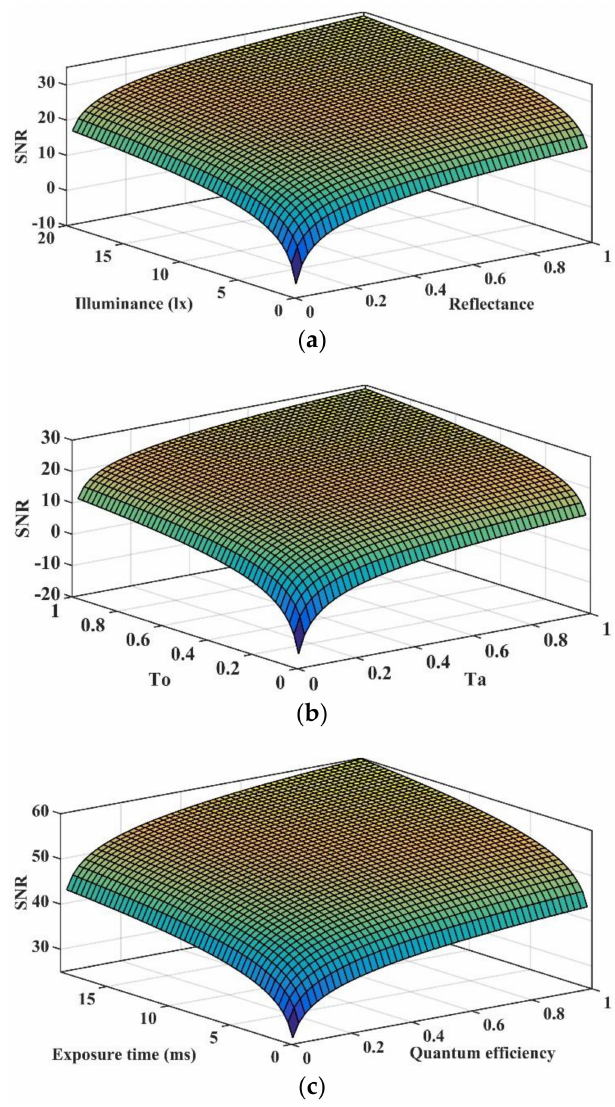
Figure 10. Influences on SNR result from the ( a ) ground object reflectance and illuminance, ( b ) atmospheric transmittance and optical transmittance, and ( c ) quantum e ffi ciency and exposure